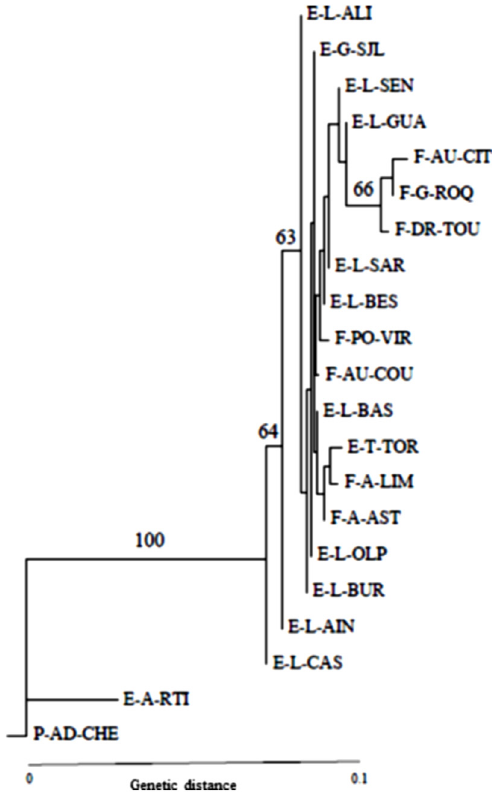
Figure 2. Neighbor-joining phenetic analysis of Nei ’ s genetic distances among 21populations of P. ariasi .